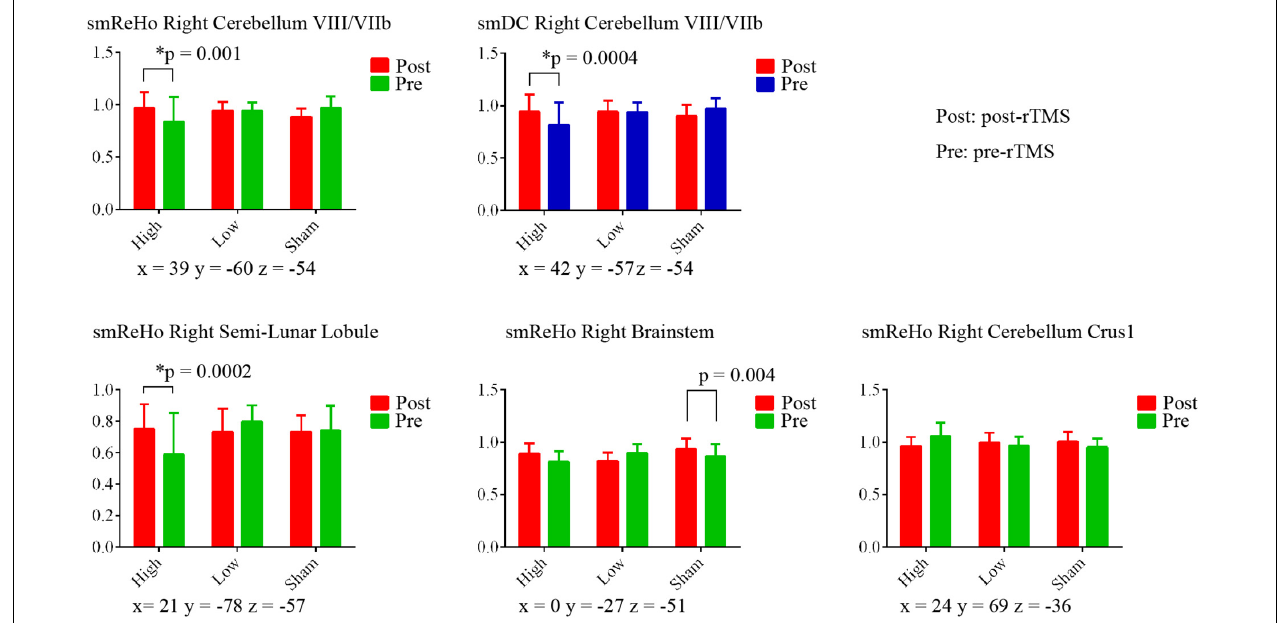
FIGURE 4 | Paired t tests between post- and pre-rTMS on ReHo and DC value of the peak voxel of F maps in the right cerebellum. The coordinates of the peak voxels were the same as Table 2 . *Still significant after Bonferroni correction of 0.05/15 = 0.0033.